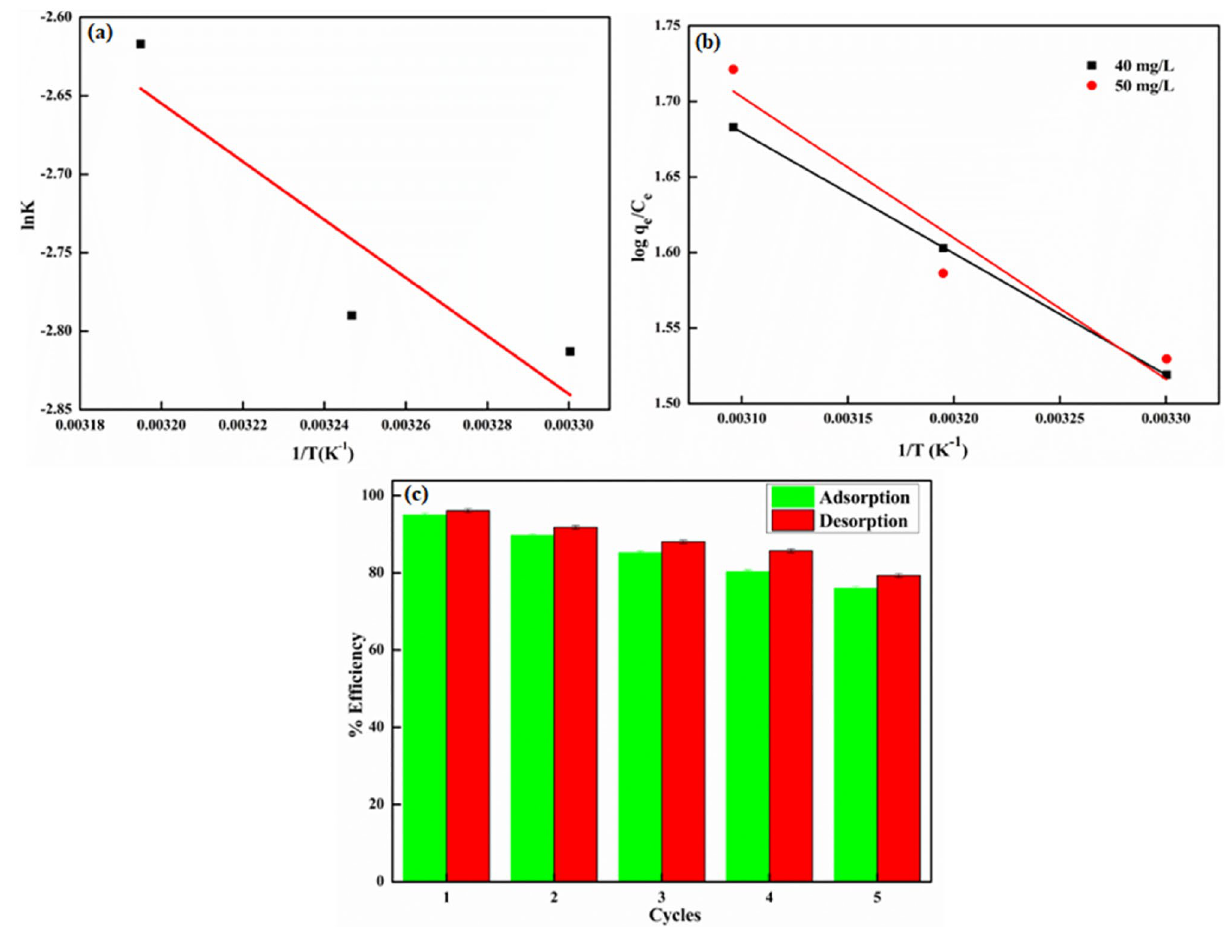
Figure 8. ( a ) Arrhenius plot, ( b ) van’t Hoff plot, ( c ) reusability potential of GG-PAAm/Er 2 O 3 nanocomposite.